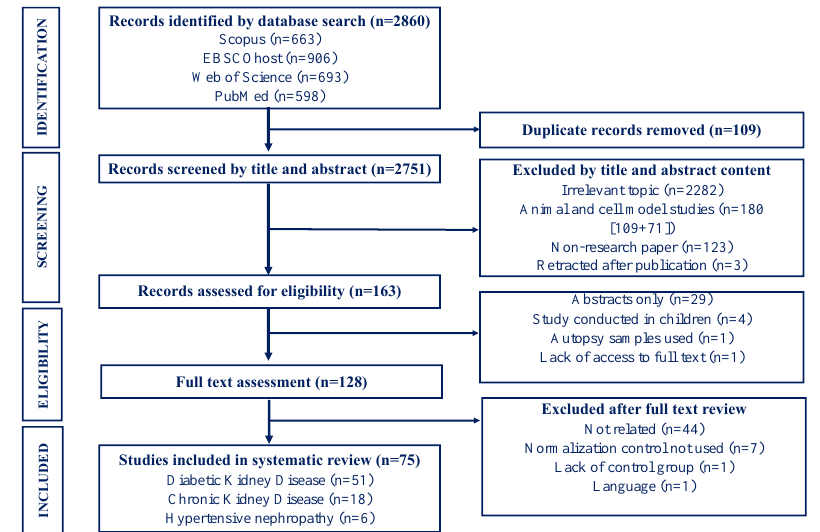
Figure 1. Selection process for studies included.